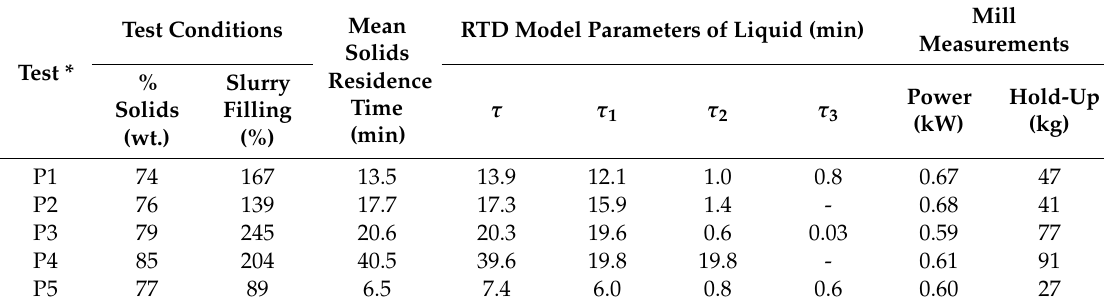
Figure 11. Comparison between experimental data and fitted RTD model for the liquid phase in the industrial mill (void symbols have not been included in fitting the model, since they represent the influence of return of tracer to the mill feed via hydrocyclone underflow). Table 3. RTD model parameters and pilot mill power and slurry hold-up recorded during steady state conditions.